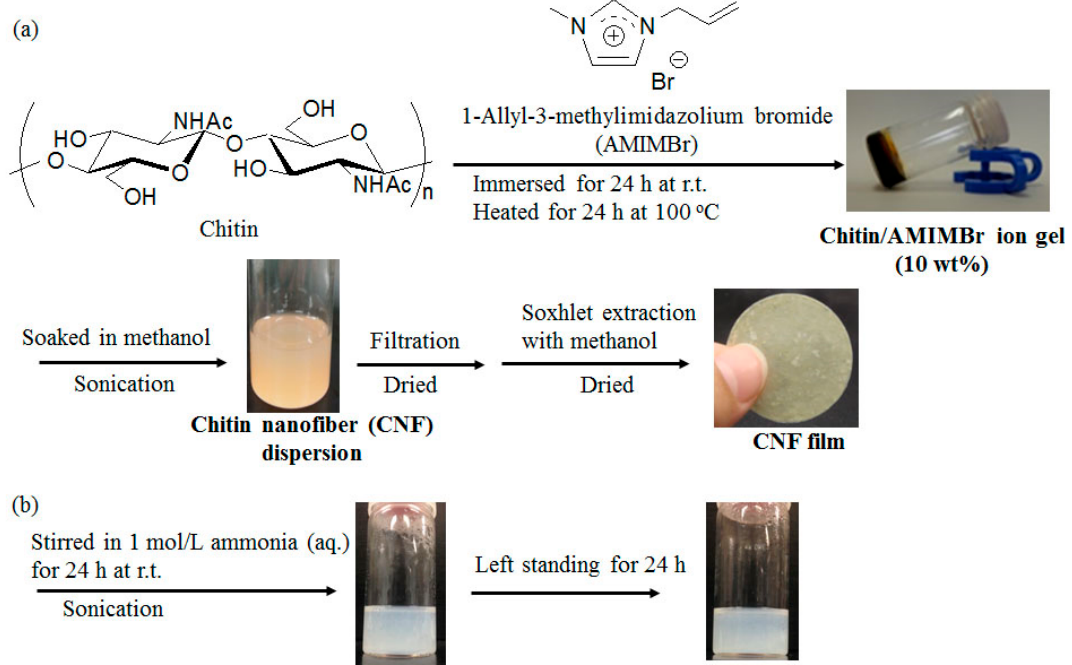
Figure 1. ( a ) Preparation of self-assembled CNF dispersion and film through regeneration from ion gel with AMIMBr using methanol; and ( b ) redispersion of CNF film in 1 mol/L ammonia aqueous solution (aq.)